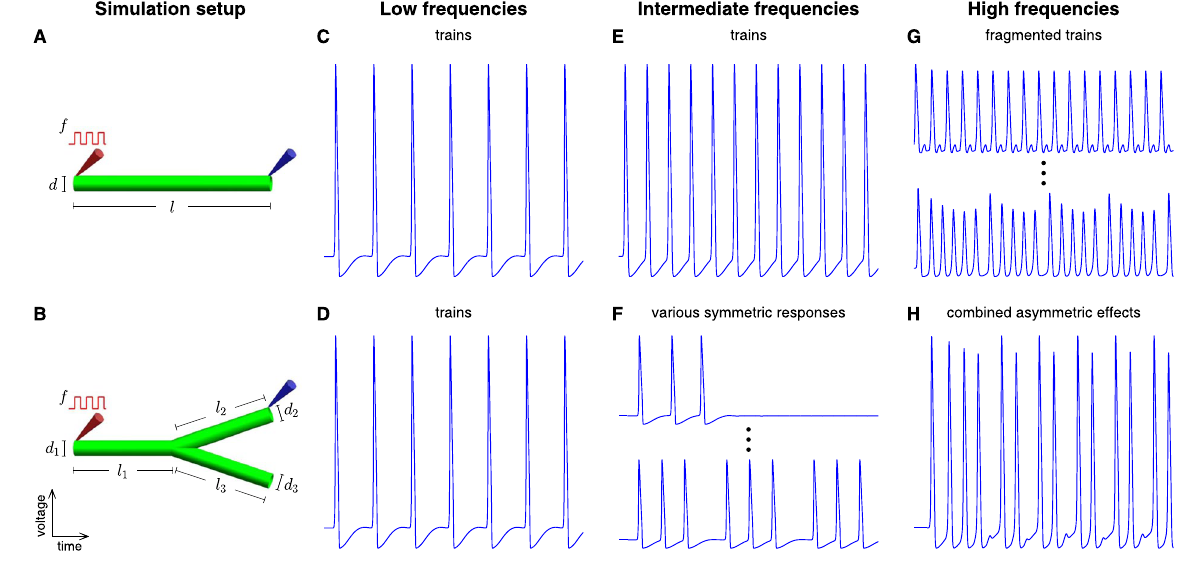
Figure 1. Representative responses to current stimuli along unbranched and branched axons. ( A , B ) Schematic diagrams of the studied axonal setups. The varied parameters are shown: stimulating frequency ( f ), segment diameter ( d ) and segment length ( l ). Stimulation and measure probes are indicated in red and blue arrows respectively. Representative responses in unbranched axons are shown for low- ( C ), intermediate- ( E ), and high- ( G ) frequency stimulations, while for branched axons the corresponding responses are shown in ( D ), ( F ) and ( H